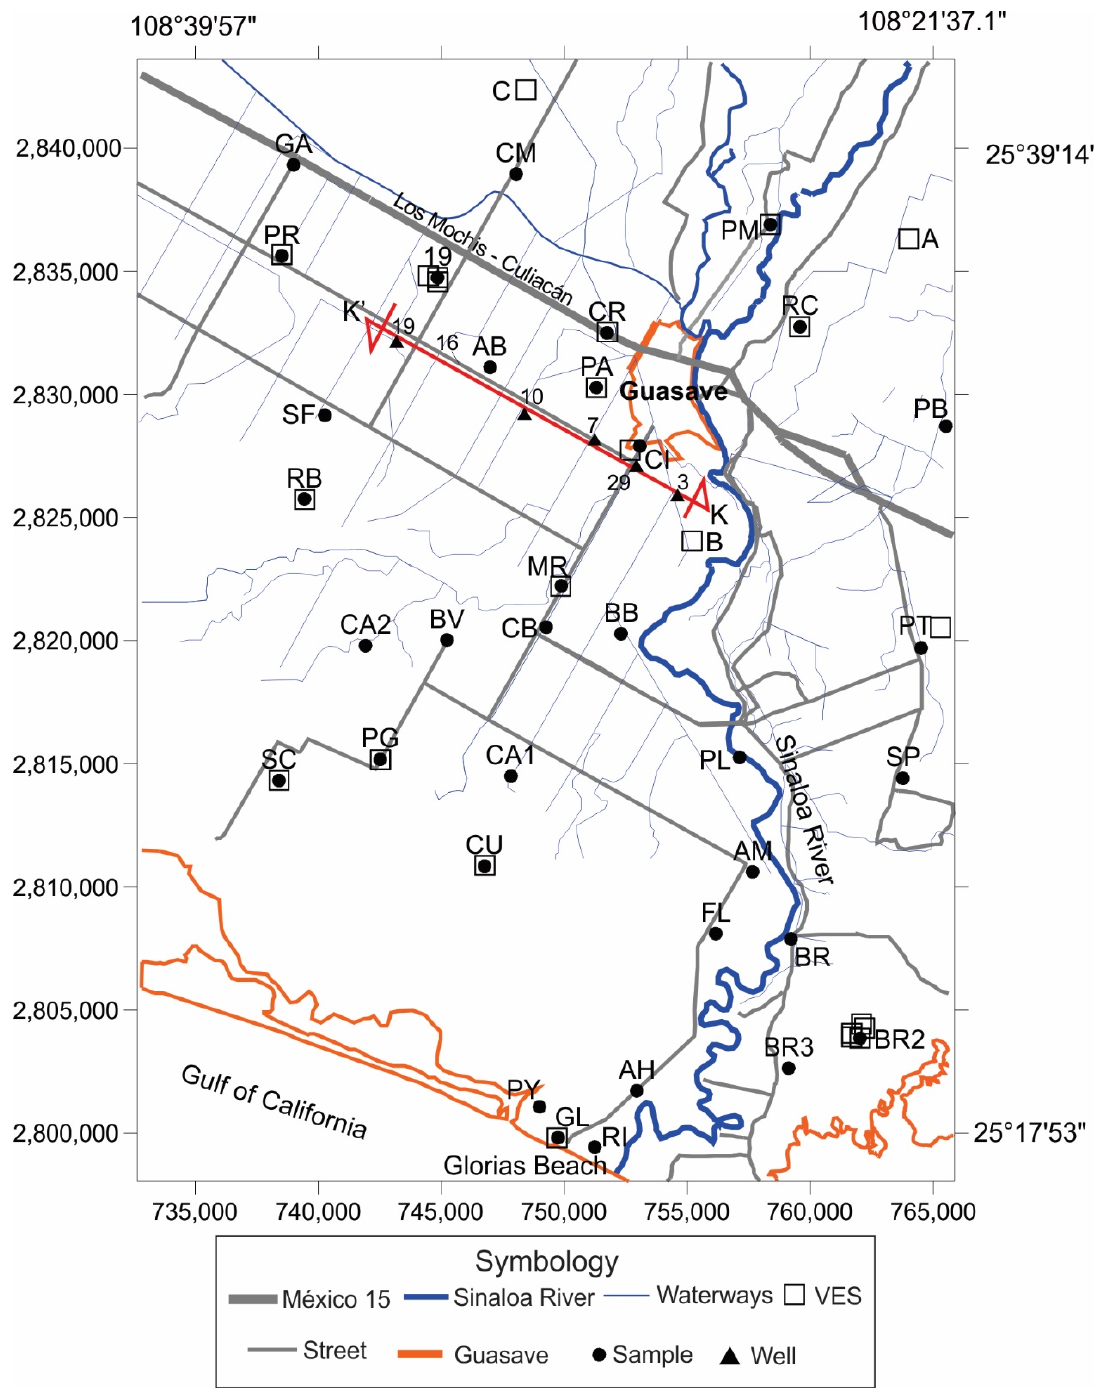
Figure 1. Study area. Locations of the water collections sites disignated with acronyms.